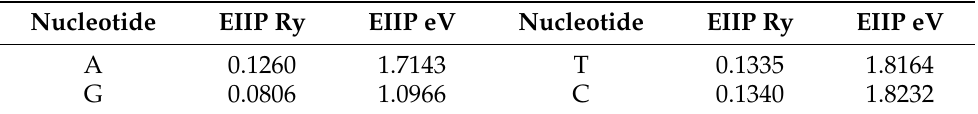
Table 1. Electron–Ion interaction potential (EIIP) values for nucleotides adenine (A), thymine (T), guanine (G), and cytosine (C). From Ref. [21,22].